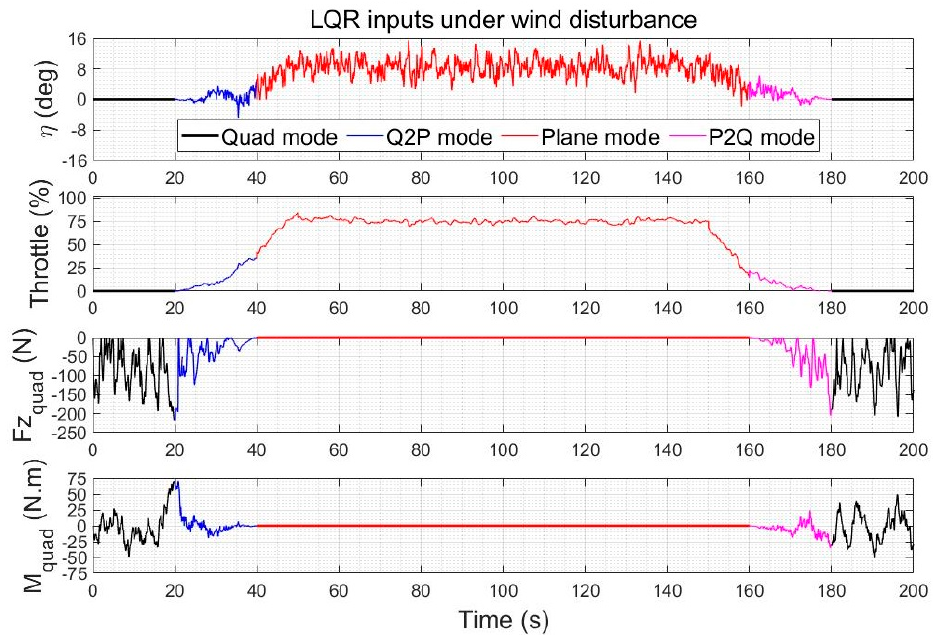
Figure 16. Quadplane control inputs using LQR during a climb − cruise − land manoeuvre under winds (no actuator fault).